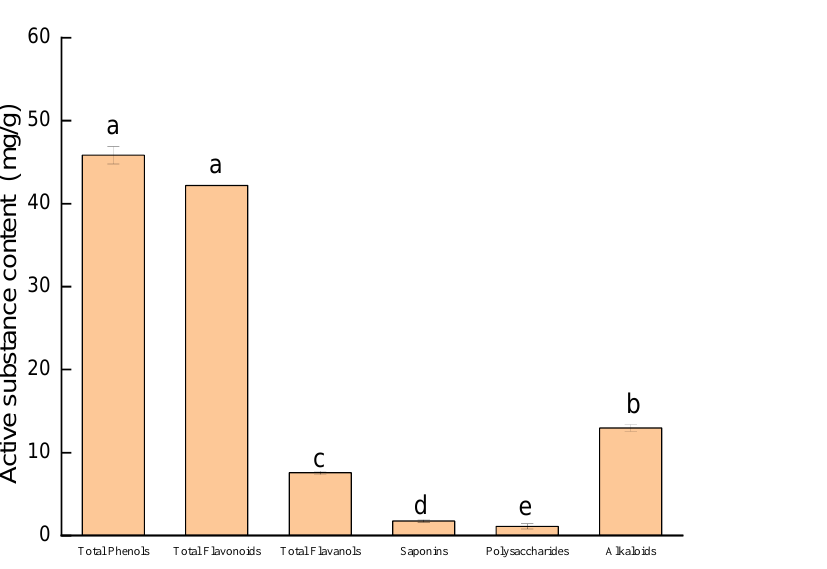
Figure 1. Active substances in Lycium barbarum leaf extract. Different lowercase letters indicate significant differences ( p < 0.05).